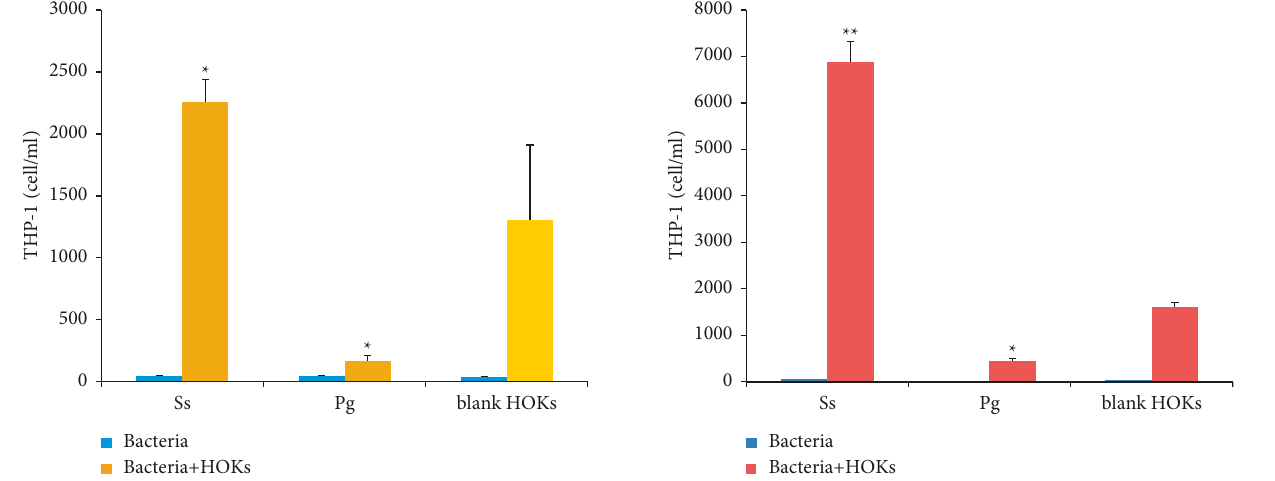
Figure 4: The number of THP-1 cells at 18 h attracted to the lower compartment of the transwell apparatus by bacteria alone, or the HOKs challenged by S . sanguinis (Ss) or P . gingivalis (Pg) for 18h. Controls: blank (light blue) and HOK alone (light pink). The results are obtained from three independent assays. Significant difference from the control group, ∗ p < 0 . 05 and ∗∗ p < 0 .